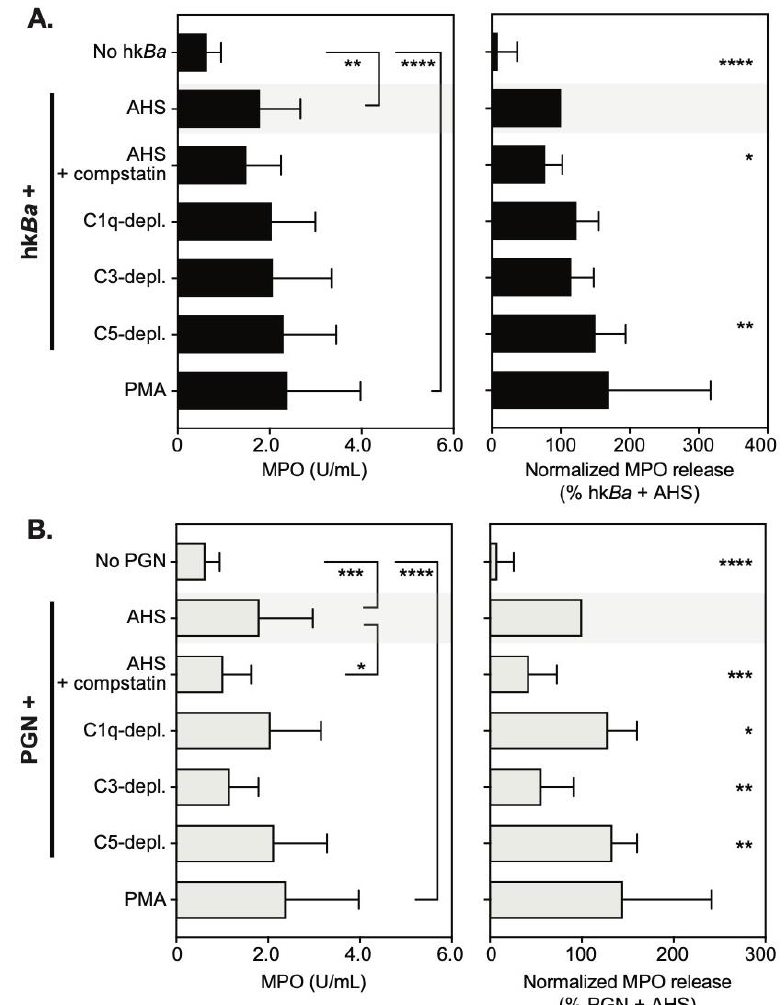
Figure 4. Quantitation of neutrophil degranulation and myeloperoxidase (MPO) release after bacteria (hk Ba , A ) or PGN ( B ) stimulation in the presence of compstatin, a C3 convertase inhibitor, or the immunodepletion of complement factors. Data are shown as mean ± SD of 10 independent donors and depict MPO activity in supernatants collected from stimulated neutrophils (left panels), changes in released MPO after the normalization to bacteria or PGN stimulation in the presence of autologous serum (AHS), which was considered 100% (right panels). Unless otherwise marked, statistically significant differences compared to bacteria and/or PGN stimulation in the presence of AHS (shaded) are depicted graphically (* p < 0.05; ** p < 0.01; *** p < 0.001; **** p < 0.0001), and were computed by repeated measures one-way ANOVA with Holm–Sidak’s multiple comparisons test (left panels) or one sample t test compared to the normalized value (right panel).